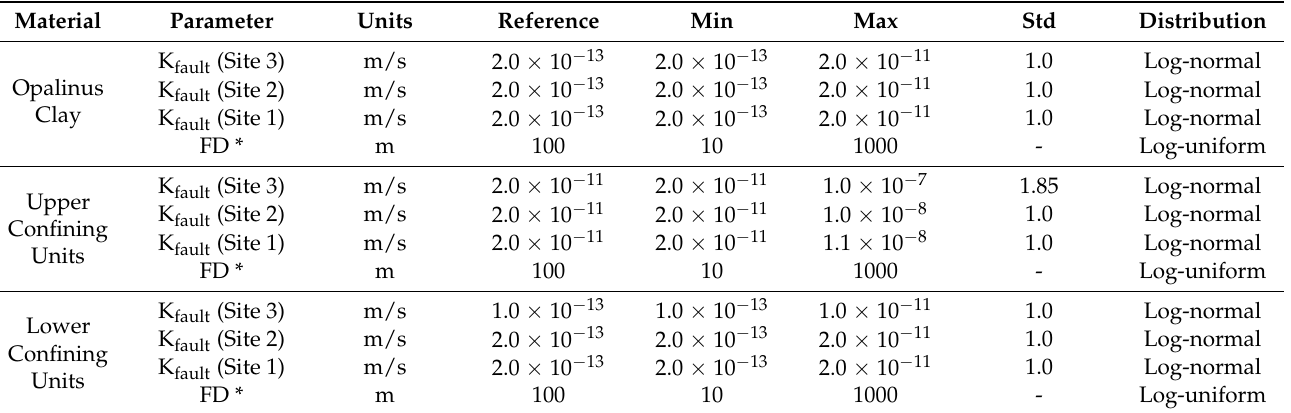
* Fracture density assuming fractures constitute 5% of the total volume in the